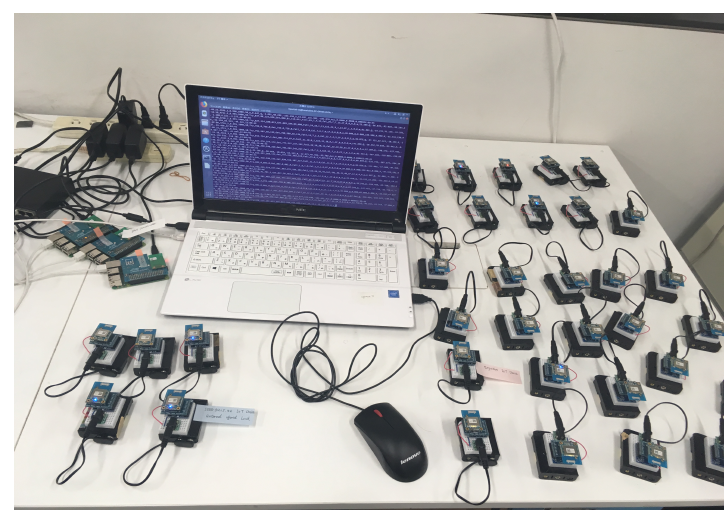
Figure 6. Photograph of the experiment setting.